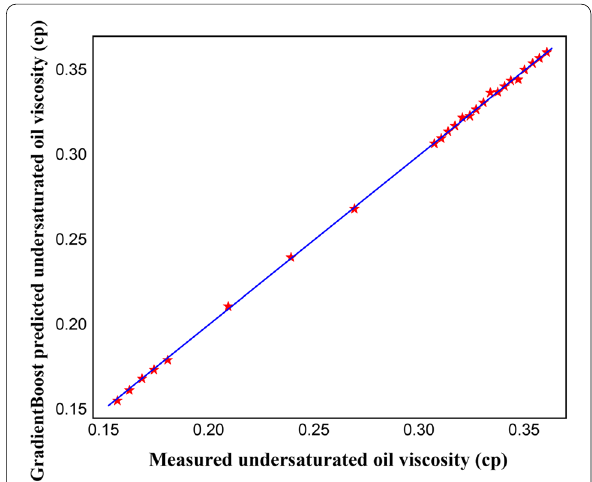
Fig. 16 Cross plot of AdaBoost-ANN predicted values versus measured values